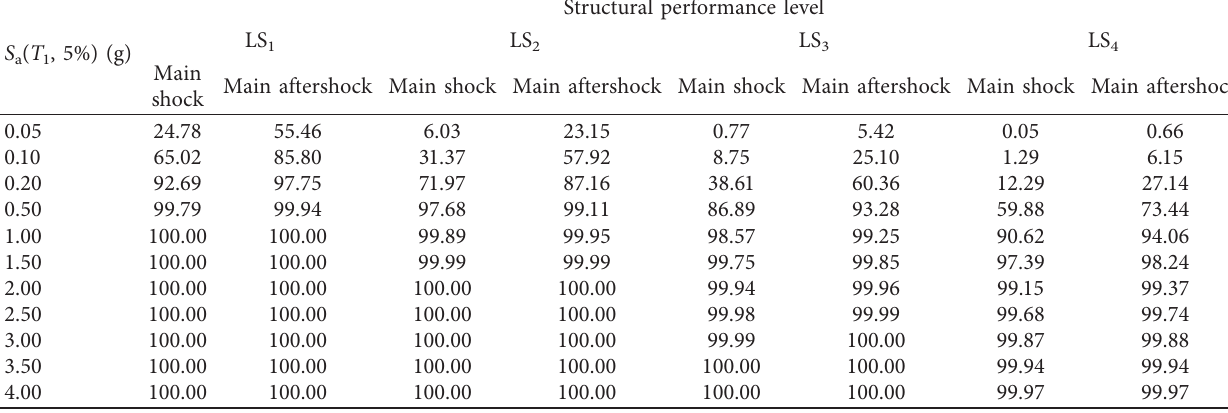
Table 10: Probability of exceeding a structural performance level under various seismic intensities. S a ( T 1 , 5%)